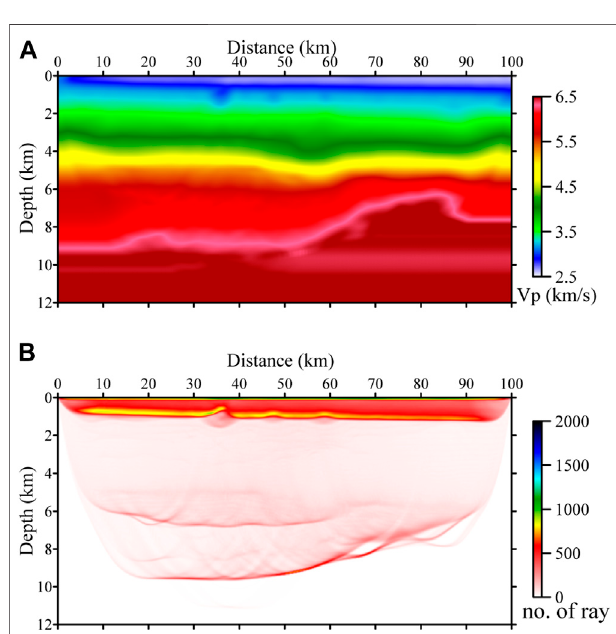
FIGURE 10 | The inverted velocity model (A) with Type-II modi fi ed geometry and (B) its ray density map. The maximum offset of the normal geometry part is 10 km. The interval of extra receivers is 1 km. The maximum offset of the modi fi ed geometry is 50 km.